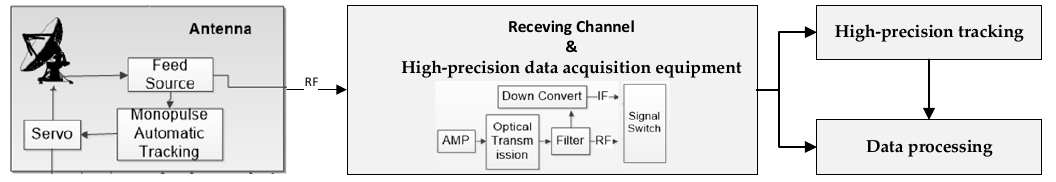
Figure 6. Flow of carrier characteristic bias estimation.